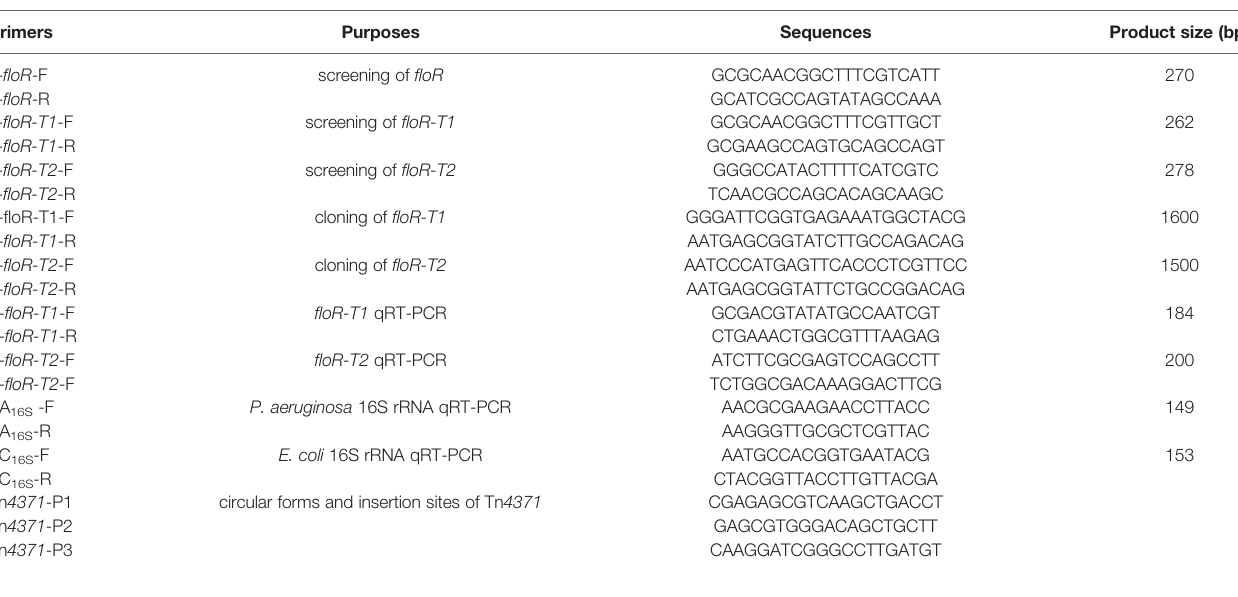
TABLE 1 | PCR primers used in this